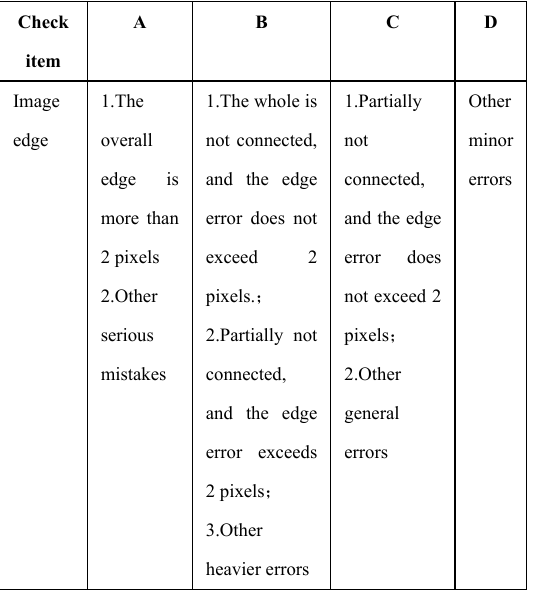
Table 4. Edge error classification table